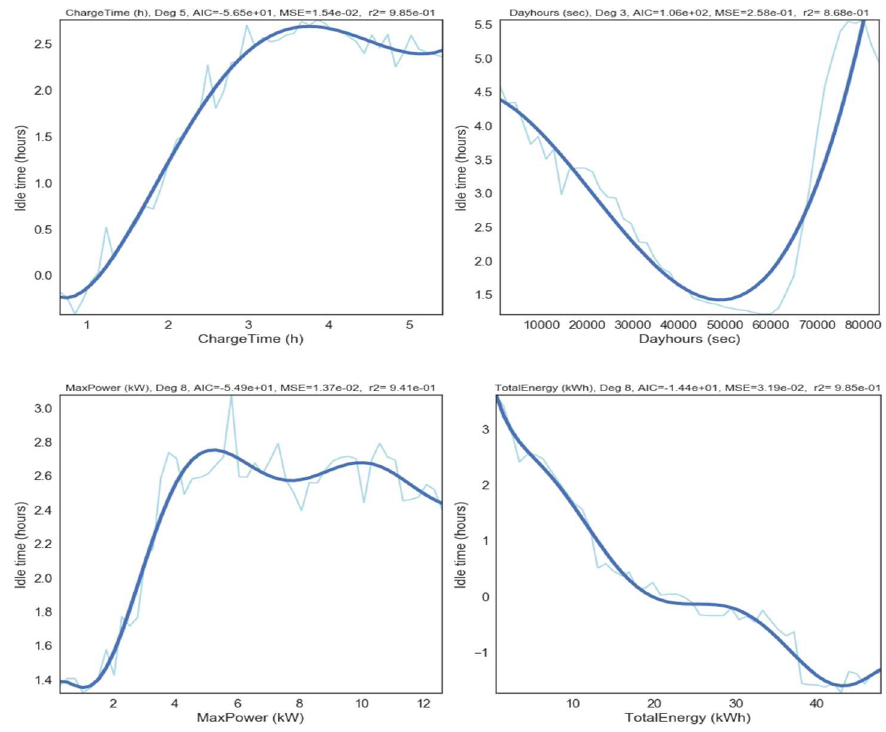
Figure 6. Partial dependencies from charge time, max. power, total energy, and day hours variables.